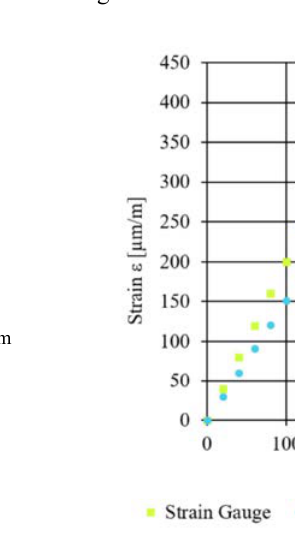
After converting the frequency signal, the non-linear relationship between frequency shift and temperature difference is specified by using a fourth-order polynomial. The coefficients of the polynomial are defined experimentally according to Froggatt (2006). The surface strain under static load is determined by the linear relationship between the measured frequency signal and the fiber strain, expressed by a strain coefficient.